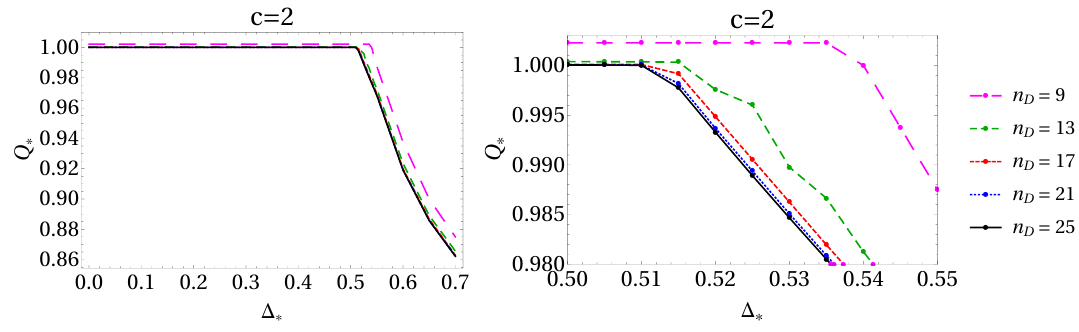
Figure 4 . We obtain an upper bound, shown here, on the smallest nonzero charge Q (cid:3) ; the bound is Q (cid:3) (cid:20) 1 for all c .